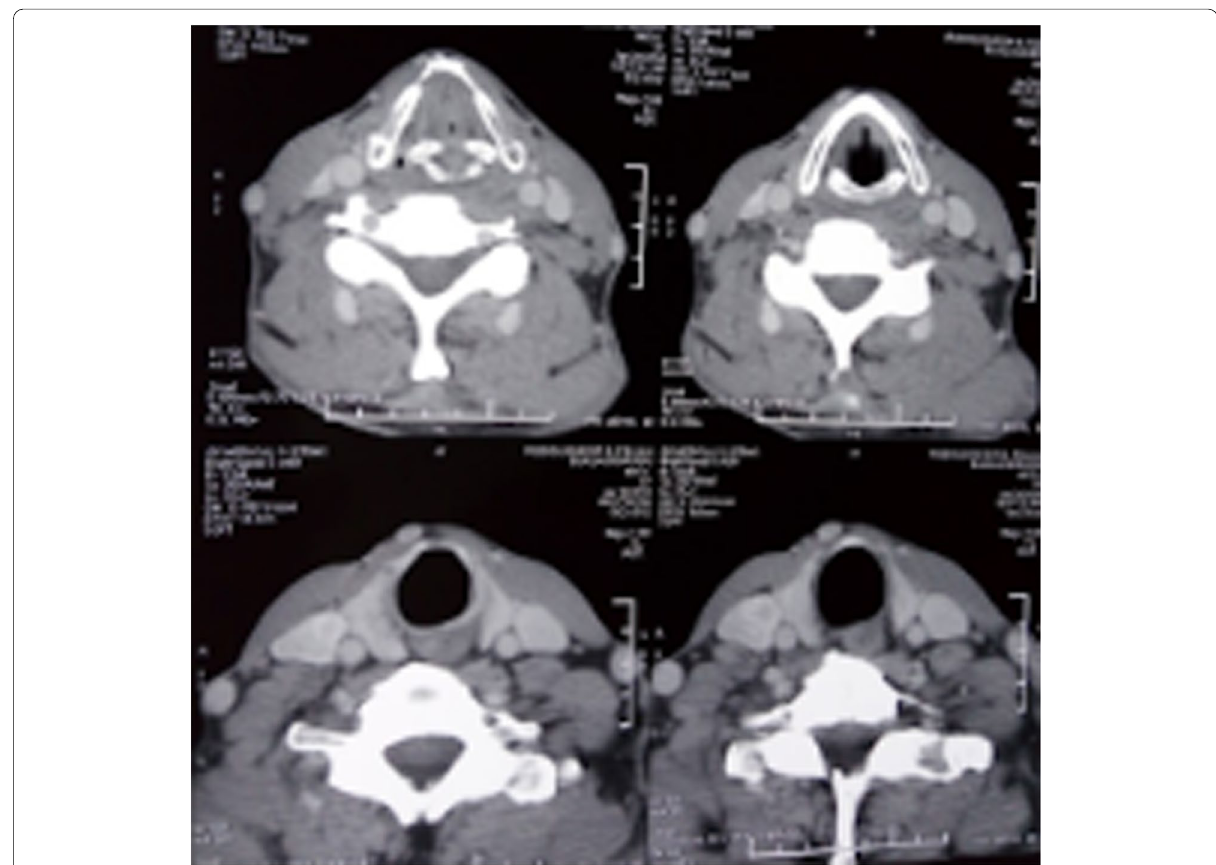
Fig. 1 Relationships between myelomatoses (Mochimatsu et